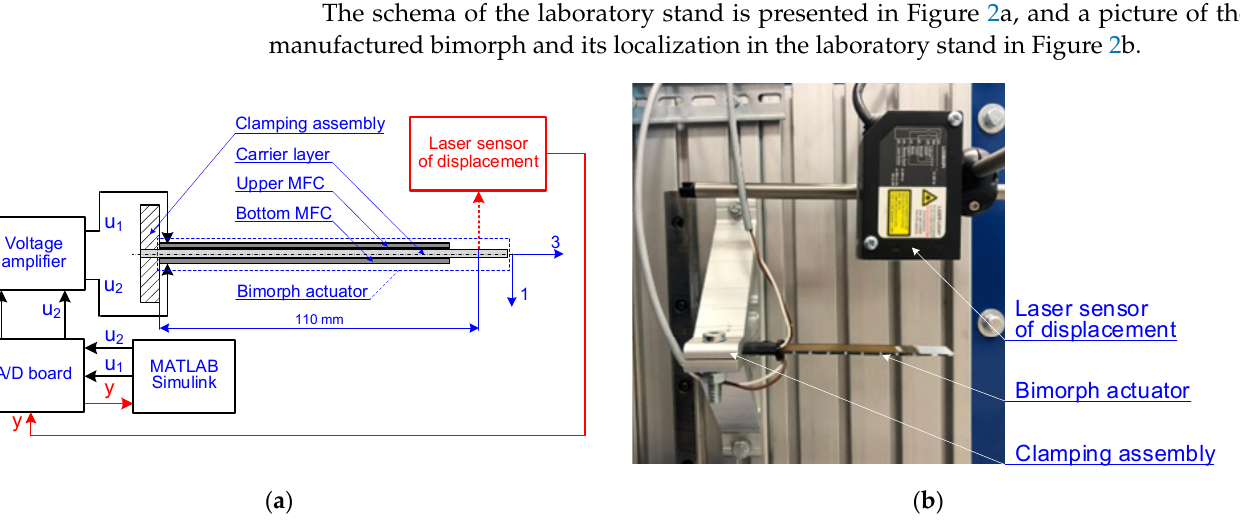
Figure 2. Laboratory stand [34]: ( a ) connection diagram of the main parts; ( b ) view of the actuator manufactured during research.